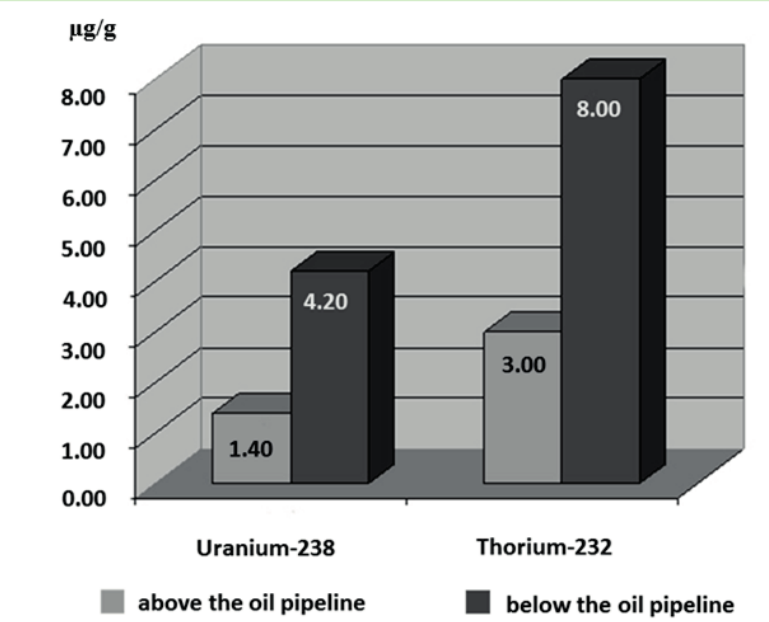
Fig. 5 Uranium and thorium content in bottom sediments above and below the oil pipeline